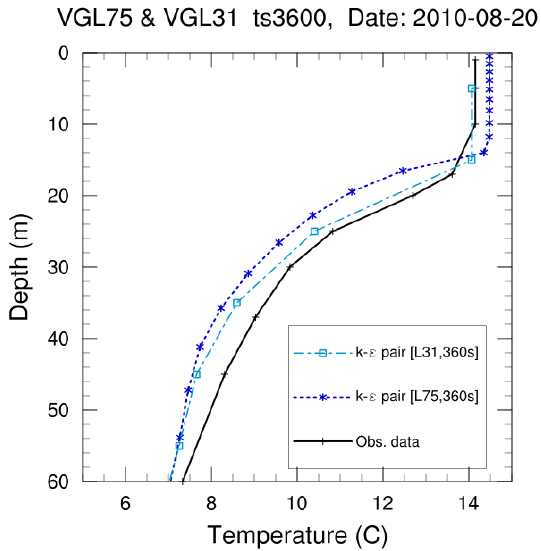
Figure 11. Daily vertical profiles of temperature for 20 Au- gust 2010: observed (black), simulated with k - ε closure, a time step of 3600s, L31 (light blue) and L75 (dark blue). The levels of obser- vations and configurations are marked with squares (L31) or stars